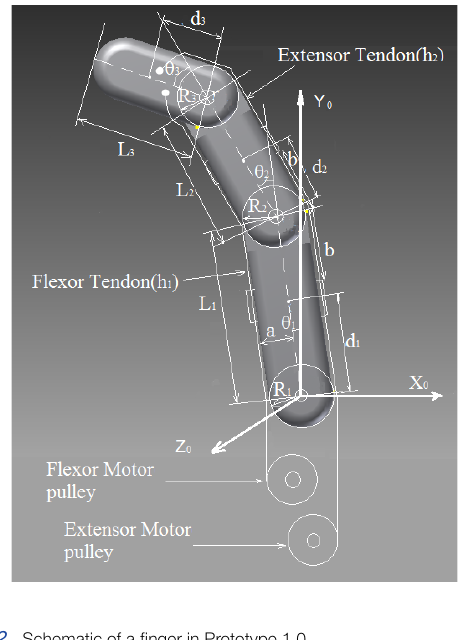
Figure 2. Schematic of a finger in Prototype